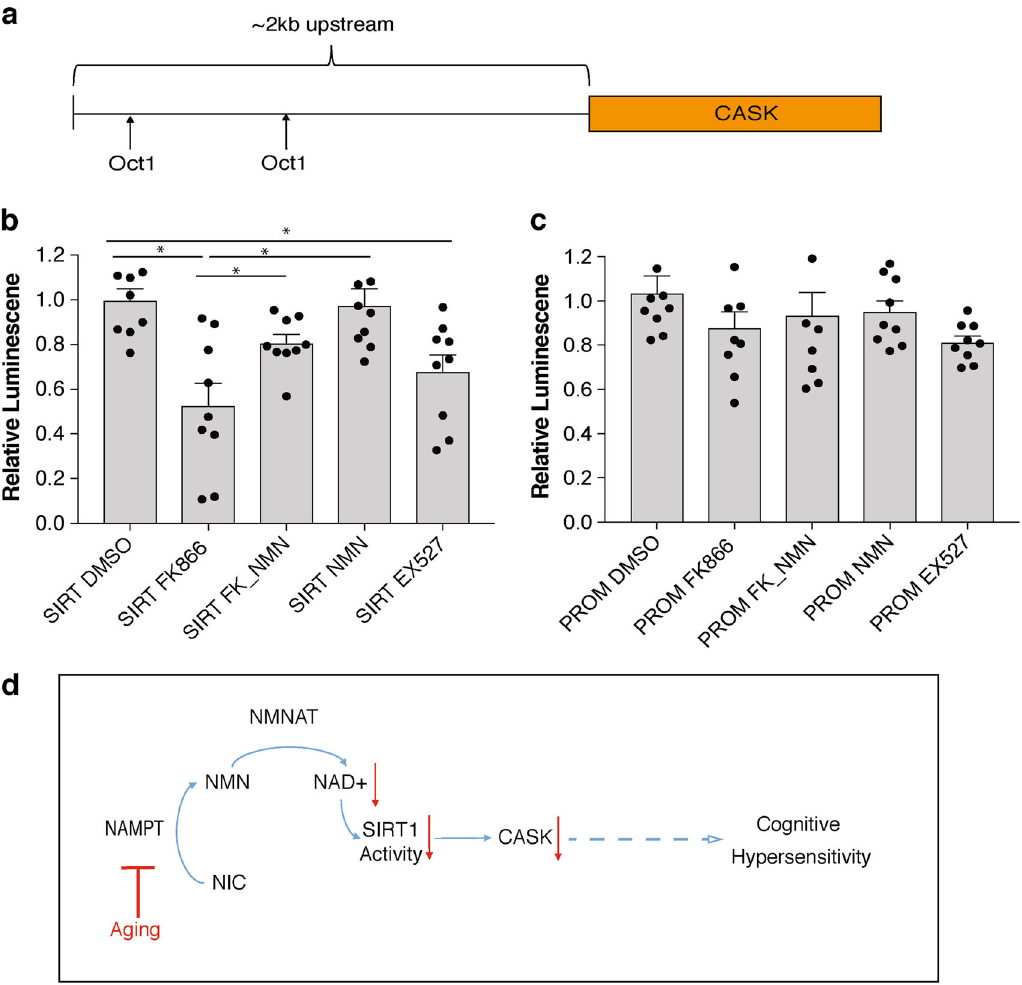
Fig. 6 Cask promoter activity is regulated in an NAD + /SIRT1-dependent manner. a The ~2 kb upstream region of the Cask gene is schematically shown. There are two potential Oct-1 binding sites. b , c Relative luciferase activities driven by an ~2 kb Cask promoter fragment were measured in HEK293 cells cotransfected with the reporter construct and a Sirt1 minigene ( b ) or its promoter-only control vector ( c ) with treatment of FK866 (100 nM), FK866 (100 nM) plus NMN (100 μ M), NMN (100 μ M), or EX527 (10 μ M). Luciferase activities were normalized to those of DMSO-treated control cells ( n = 9; * p < 0.05, one-way ANOVA with LSD post hoc test). Data are presented as mean ± SE. d A proposed model for the relationship between age-associated, NAD + /SIRT1-mediated reduction in Cask expression and cognitive hypersensitivity in